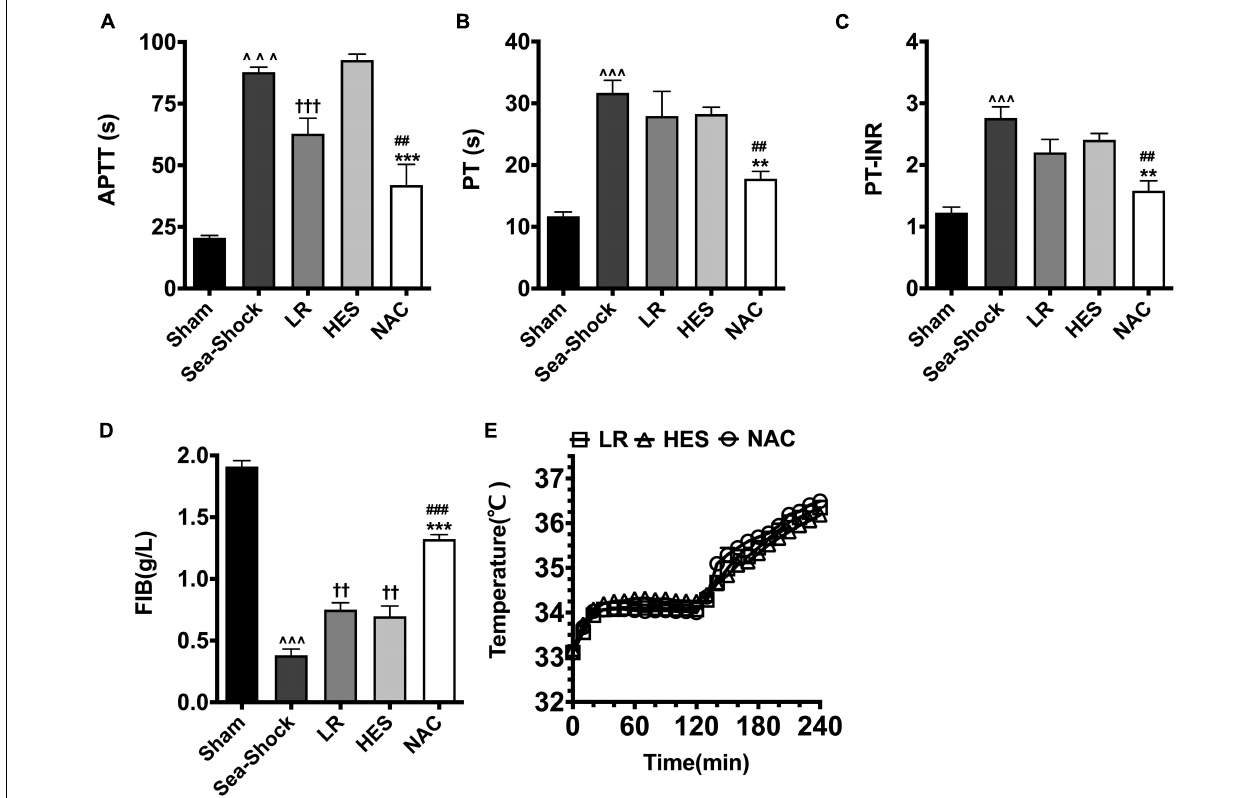
FIGURE 2 | Effects of LR solution, HES solution, and LR solution with the addition of NAC (30 mg/kg) on coagulation function and core temperature. (A) APTT; (D) FIB; (B) PT; (C) PT-INR; (E) temperature. LR, Lactated Ringer’s; HES, Hetastarch; NAC, LR solution with the addition of NAC (30 mg/kg). Data presented as mean ± standard deviation ( n = 8/group). ∧∧∧ P < 0.001, Sea-Shock group versus baseline; †† P < 0.01, ††† P < 0.001, LR group or HES group versus Sea-Shock group; ## P < 0.01, ### P < 0.001, LR group versus NAC group; ** P < 0.01, *** P < 0.001, HES group versus NAC group.